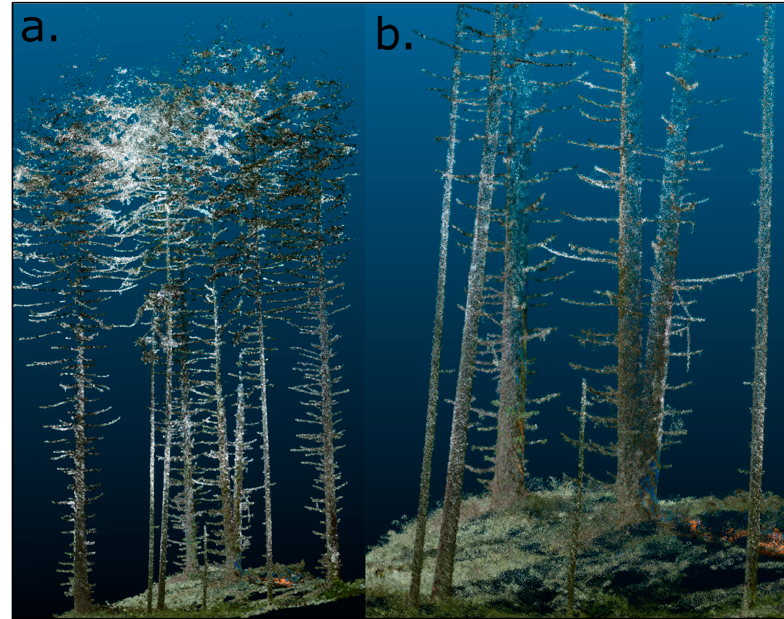
Remote Sens. 2022 , 14 , x FOR PEER REVIEW Figure 3. Handheld LiDAR model for plot three: ( a ) extent and ( b ) detail. Figure 3. Handheld LiDAR model for plot three: ( a ) extent and ( b ) detail.